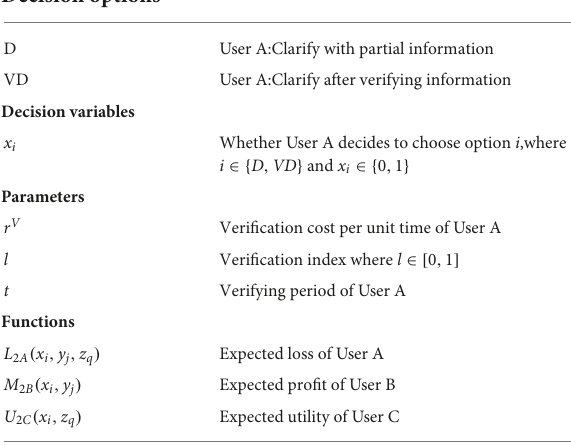
TABLE 3 Notations different from Model 1 in Model